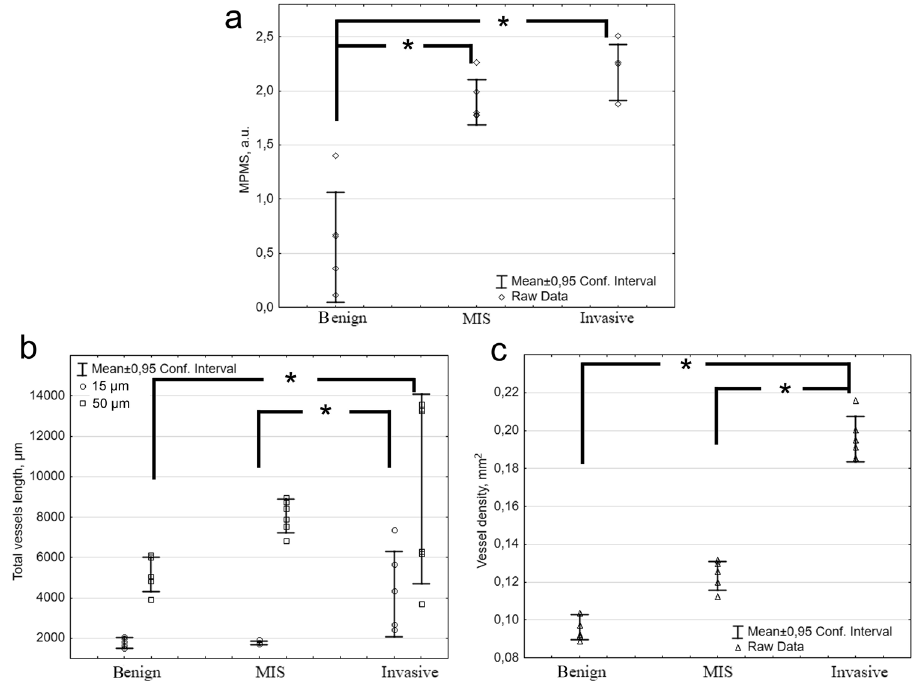
Figure 5. The quantitative analysis of malignant features of dermoscopic equivocal lesions revealed by MPM and OCA. The MPMS ( a ), total length of small (≤ 15 μm) and large caliber vessels (≥ 50 μm) ( b ) and vessel density ( c ) for benign melanocytic lesions, melanoma in situ (MIS) and invasive melanoma. Whiskers show the mean and 95% confidence interval. Rhombus, squares, cycles and triangles display the measurements for individual patients. *, p < 0.05.